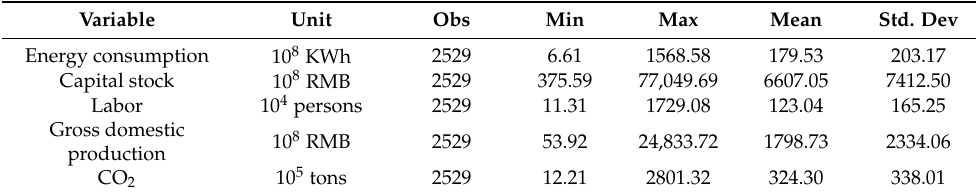
Table 1. Summary statistics of DEA